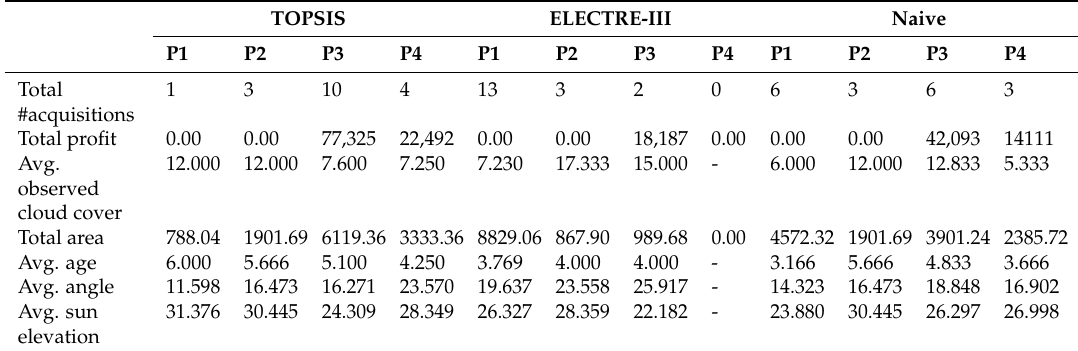
Table 4. The performance of different scoring approaches relative to priority. It should be noted that ELECTRE-III utilizes equal criteria weighting and the previously specified threshold